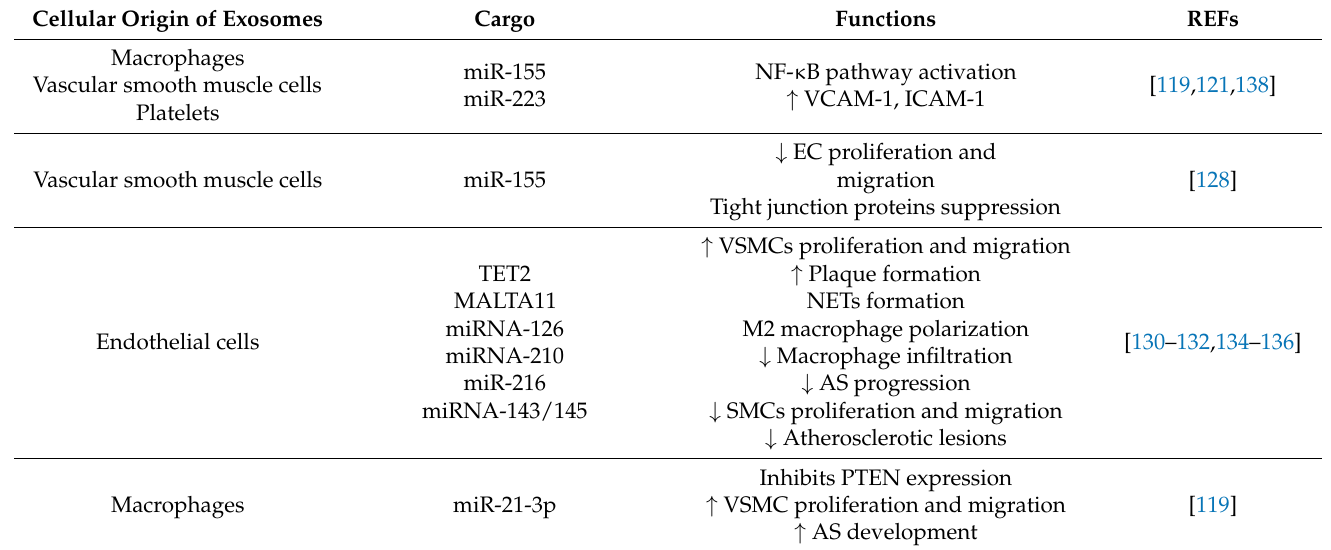
Table 3. Exosomal cargoes involved in vascular-protective and atherosclerotic